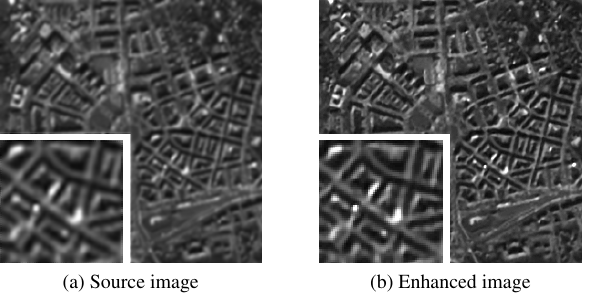
Figure 1: Enhancement of spatial resolution through single-image super